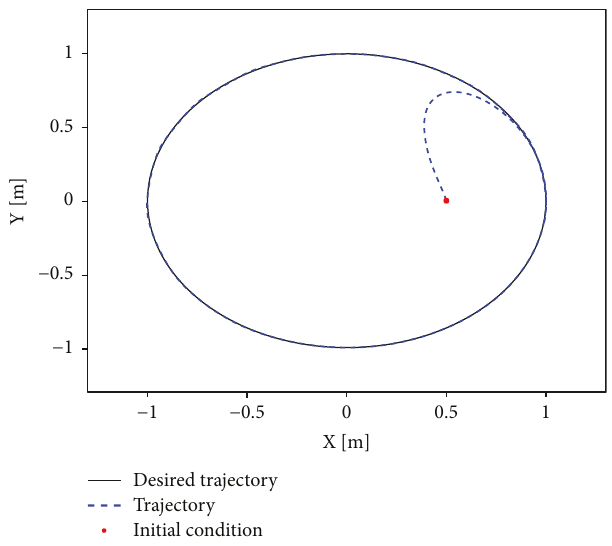
Figure 4: Robot trajectory around X and Y directions.